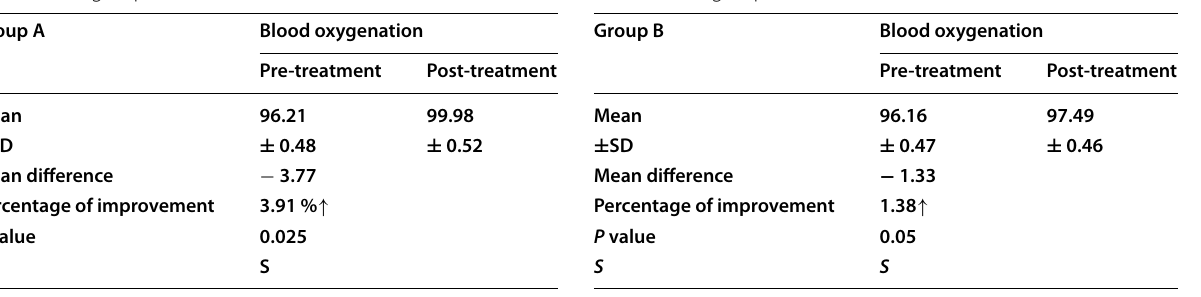
Data are expressed as mean SD ± NS p > 0.05 not significant = = Table 2 Mean values of blood oxygenation pre- and post- treatment of group A